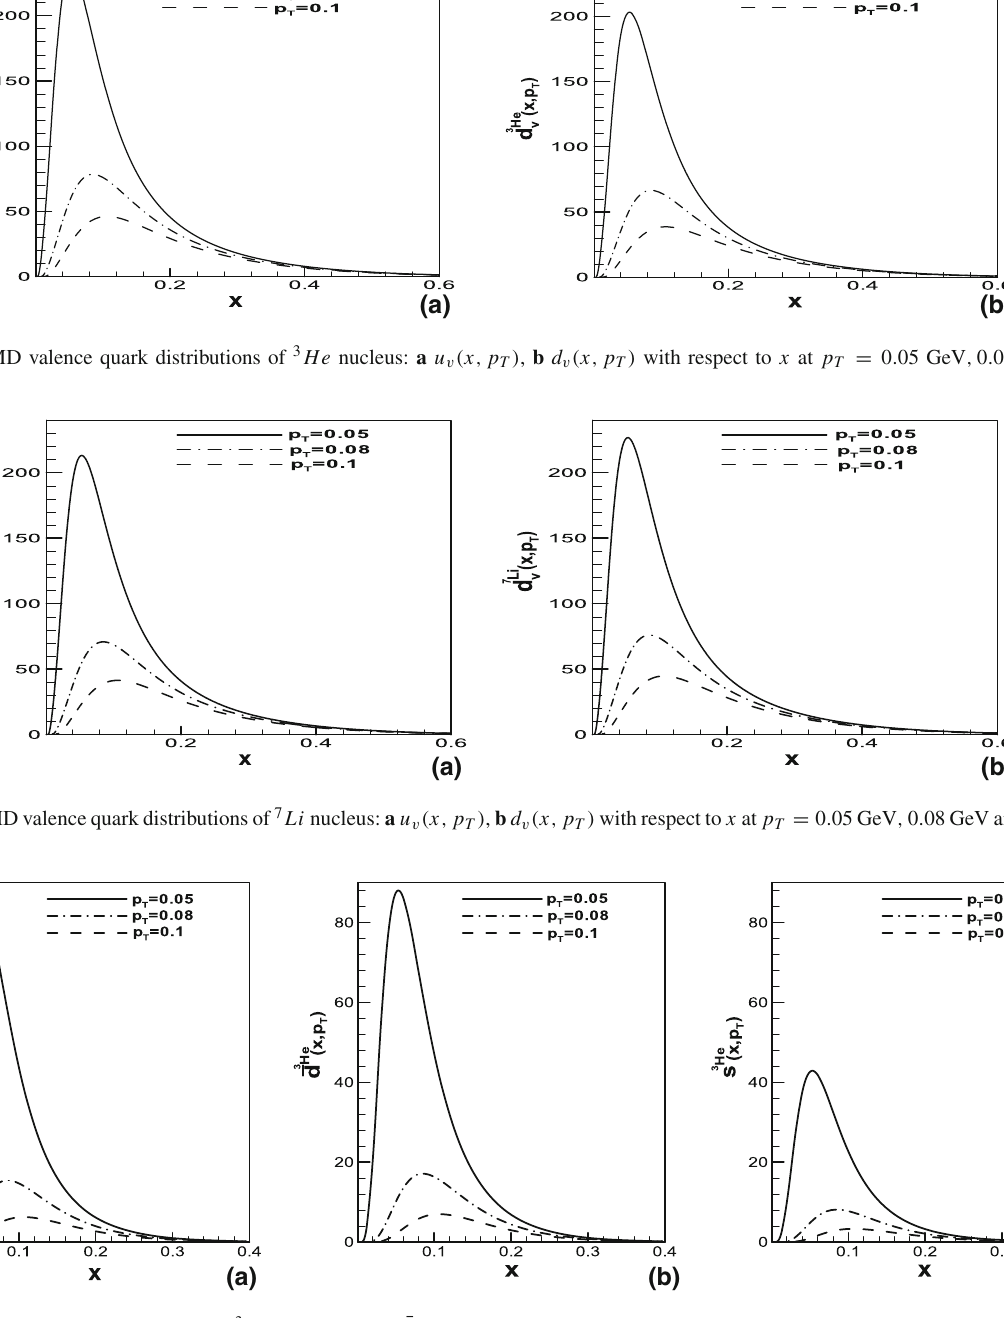
Fig. 3 The TMD sea quak distributions of 3 He , a ¯ u ( x , p T ) , b ¯ d ( x , p T ) , c s ( x , p T ) , with respect to x at p T = 0 . 05 GeV , 0 . 08 GeV and 0 . 1